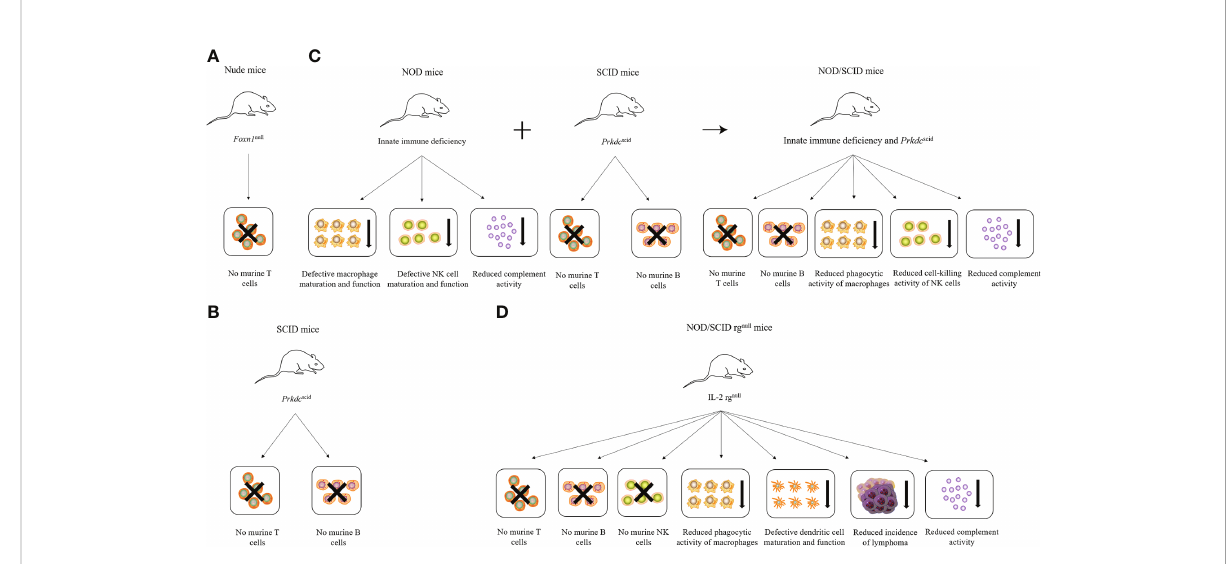
FIGURE 1 Characteristics of different immunode fi cient mice. (A) Nude mice lack T cells due to Foxn1 mutation. (B) SCID mice lack T and B cells due to Prkdc mutation. (C) NOD mice combined with SCID mice produce NOD/SCID mice, which lack T and B cells and have reduced phagocytic activity of macrophages, the cell-killing activity of NK cells, and complement activity. (D) NOD/SCID rg null mice lack T, B, and NK cells and have reduced phagocytic activity of macrophages and complement activity, defective dendritic cell maturation and function, and reduced incidence of lymphoma due to the loss of the IL-2 receptor g